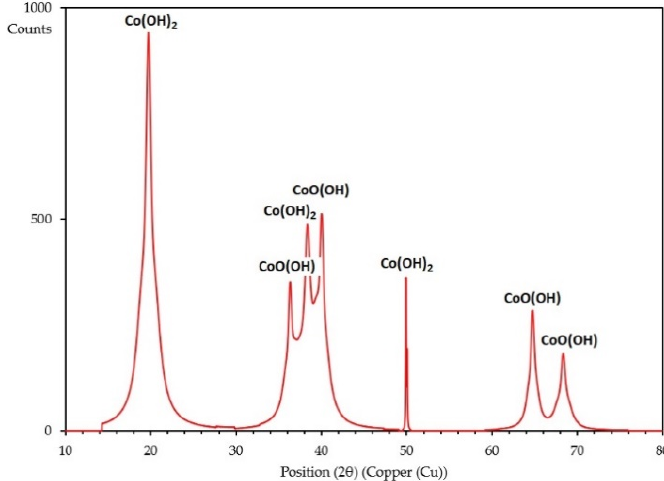
Figure 9. XRD powder pattern of the cobalt product.